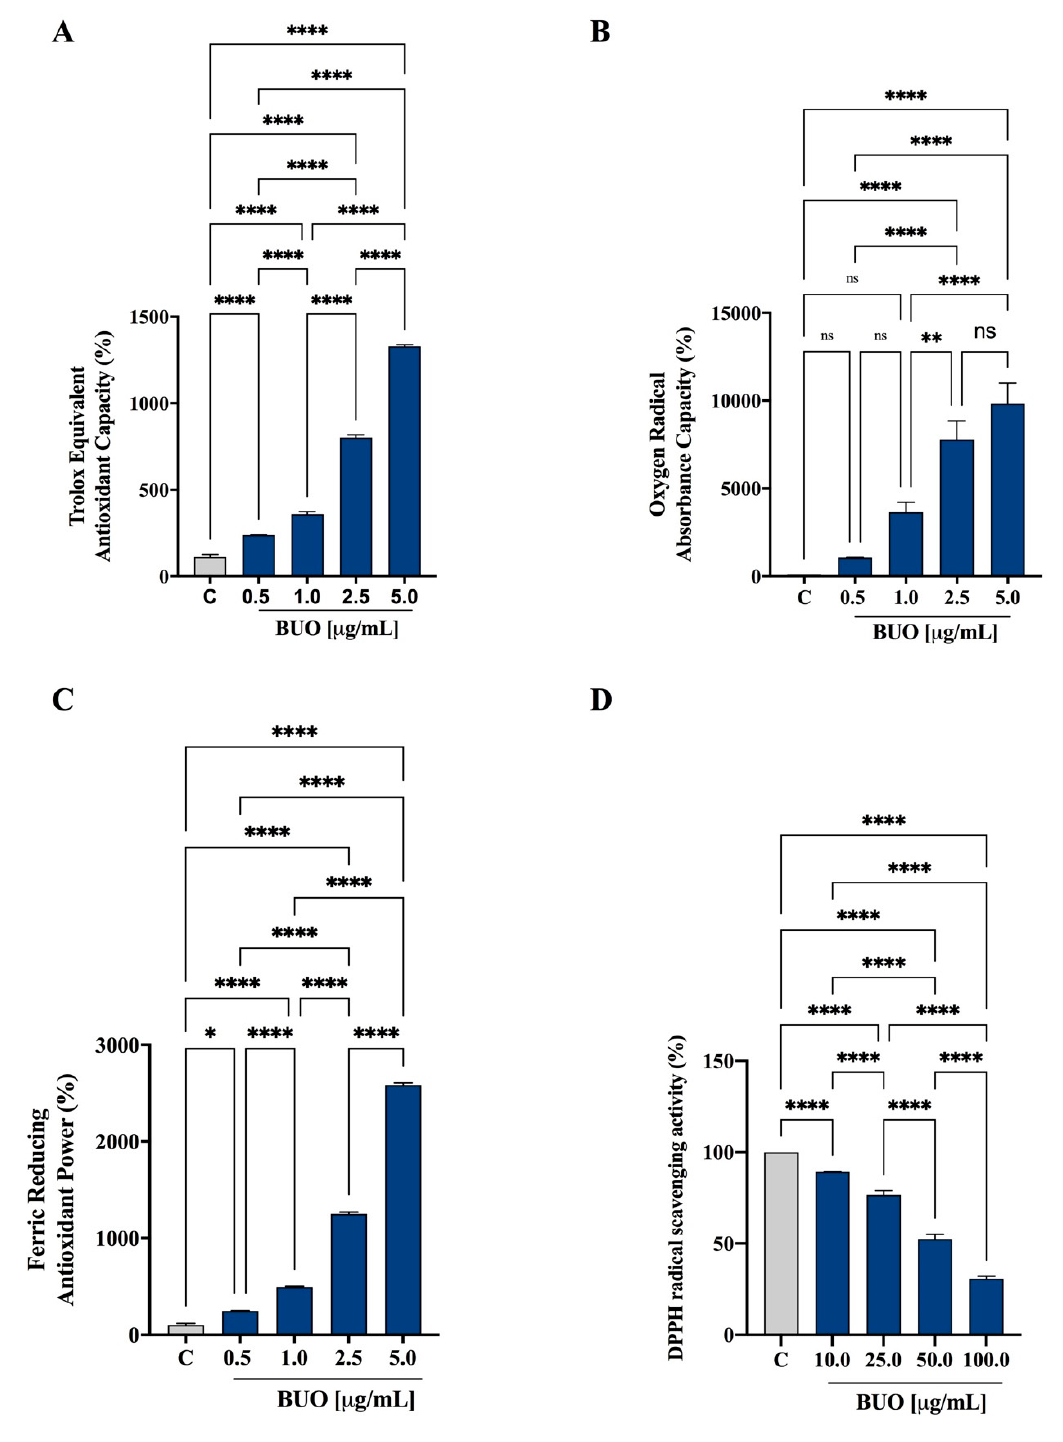
Figure 1. In vitro antioxidant power evaluation of the phenolic extract (BUO) extract by 2,2-azino-bis-(3-ethylbenzothiazoline-6-sulfonic acid (ABTS) ( A ), Oxygen Radical Absorbance Capacity (ORAC) ( B ), ferric reducing antioxidant power (FRAP) ( C ), and 2,2-diphenyl-1-picrylhydrazyl (DPPH) ( D ) assays. The data points represent the averages ± SD of four independent experiments performed in duplicate. All data sets were analyzed by One-way ANOVA followed by Tukey’s post-hoc test. ns: not significant and C: control sample (H 2 O). (*) p < 0.5; (**) p < 0.01; (****) p < 0.0001. 3.2. The BUO Extract Decreases the H 2 O 2 -Induced Oxidative Stress in Hepatic and Intestinal Cells